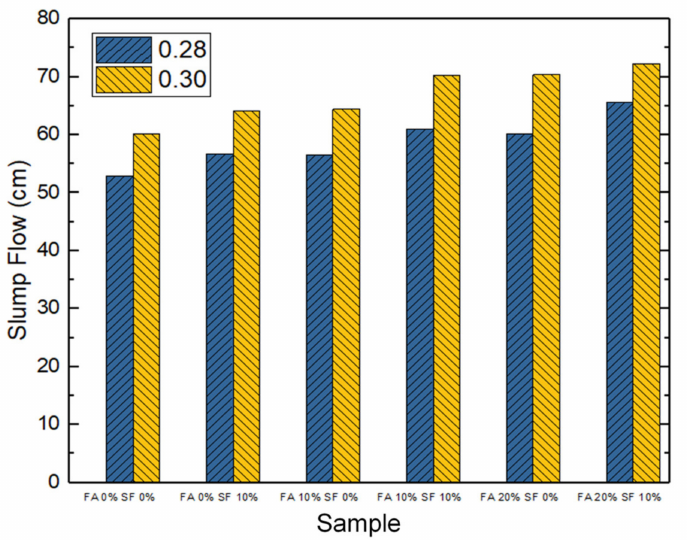
Figure 3. Slump flow data for the 12 HPC proportioning conditions (mixture combinations) with a water/binder (W/B) ratio of 0.28 or 0.30. Note: FA = fly ash; SF = silica